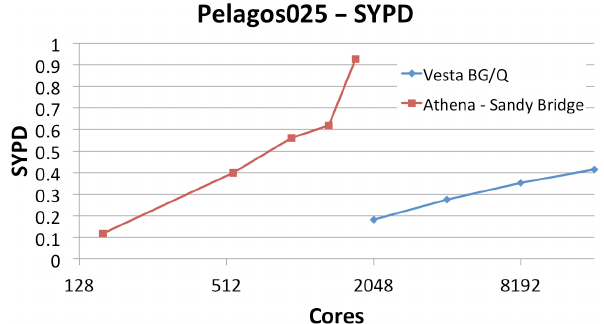
Figure 4. Scalability of the PELAGOS025 configuration: compar- ison between the results obtained on ATHENA and VESTA. The red line represents the simulated years per day of the model on ATHENA, the blue line on